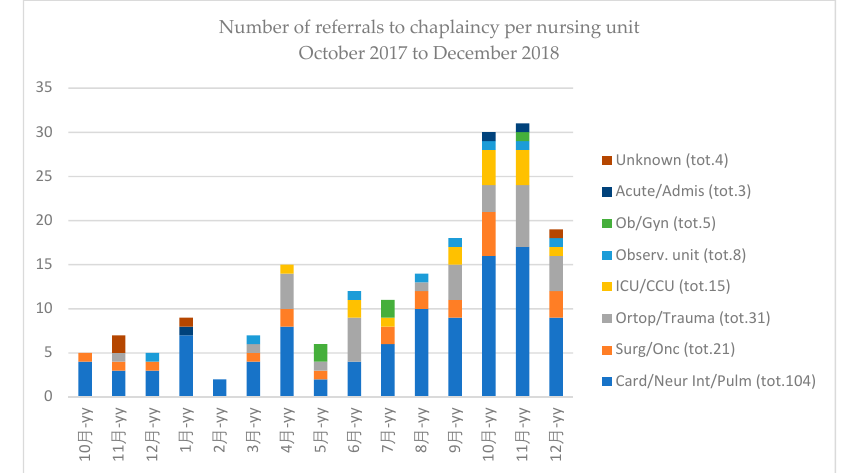
Figure 1. Referral to chaplaincy during the project.